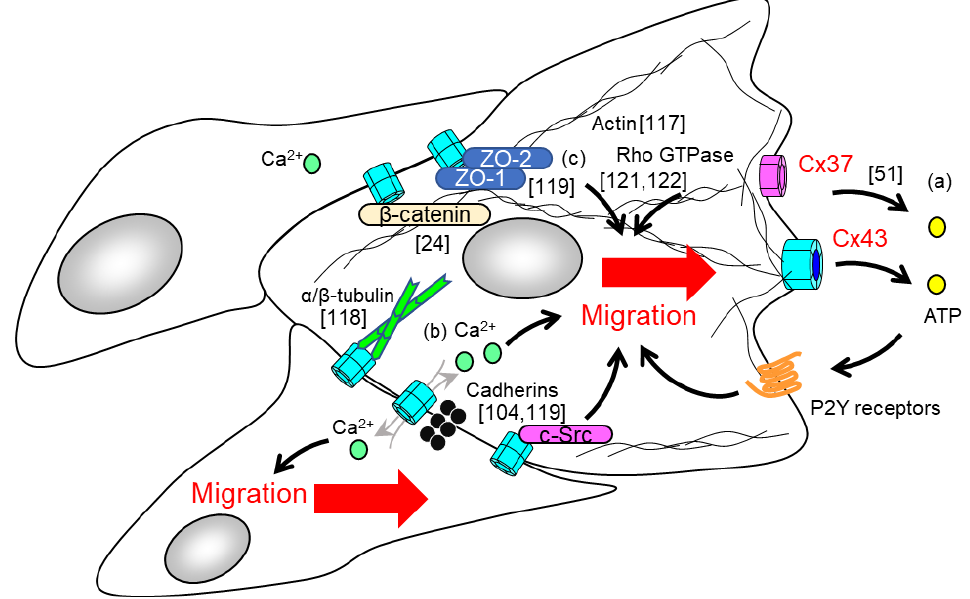
Figure 2. Endothelial Cx-dependent regulation of cell migration in angiogenesis. Gap junctions and Cxs regulate cell migration via channel function dependent and independent